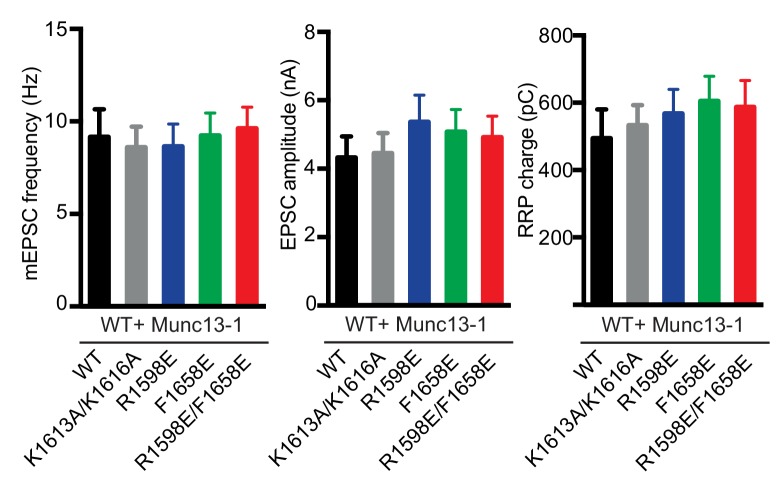
Electrophysiological analysis of the functional effects of overexpressing Munc13-1 bearing mutations in the putative membrane-binding loops and the polybasic region of the C2C domain.Summary plots of average mEPSC frequencies, EPSC amplitudes and RRP charges from WT autaptic hippocampal neurons with overexpression of either Munc13-1 WT or the indicated Munc13-1 C2C point mutants. The data from approximately 40 neurons per group were pooled together from two independent cultures. Values indicate mean ±SEM. No statistically significant differences between the different groups were observed by a Kruskal Wallis test.